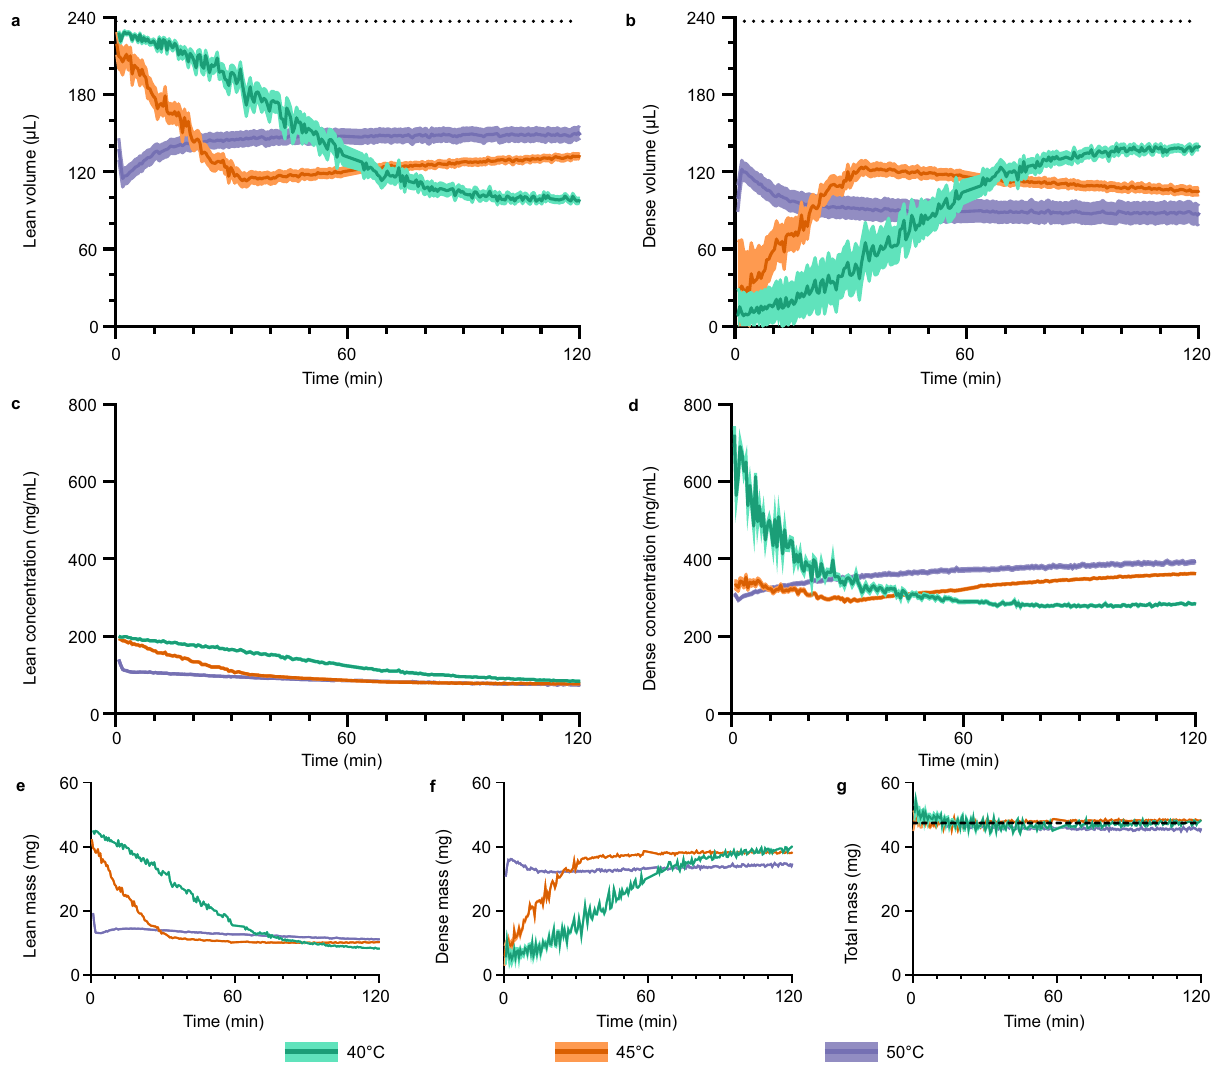
Fig. 4 Fast kinetics of BSA LLPS at different temperatures as characterised by bulk-detected NMR. a , b Apparent volumes of the lean and dense phases, respectively, in the observed sample volume. Volumes were calculated based on deconvoluted integrals of the TFE signals and the known total observed volume (236.8 µ L, marked by dotted lines). c , d Concentrations of the lean and dense phases, respectively. Concentrations were calculated based on deconvoluted peak chemical shifts and protein concentration calibration curve. e , f Mass of BSA in the lean and dense phases, respectively, present in the observed sample volume. Masses calculated from the apparent volumes and concentrations of each phase. g Total mass in the observed volume, based on calculated mass in the lean and dense phases. Dashed line indicates the expected total mass in the observed volume (47.36 mg). For all plots, line plots are the calculated values, while the shaded regions represent parameter error estimates following propagation of 95% con fi dence intervals in MATLAB fi tting. Individual data points represent independent deconvolution results for different time points collected at 0.5 min intervals. Source data are provided as a Source Data fi